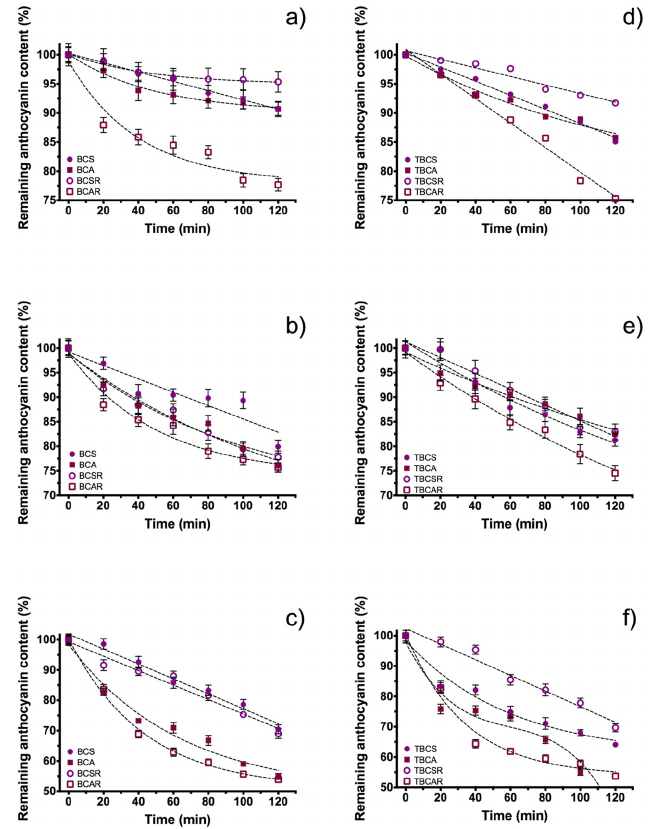
Figure 5. Anthocyanin content as function of time at different temperatures; ( a , d ) at 40 °C, ( b , e ) at 60 °C, and ( c , f ) at 80 °C. Samples extracted with ethanol/citric acid (BCS) and ethanol/acetic acid (BCA), samples after resin column (BCSR and BCAR), and microencapsulated samples using TEOS (TBCS, TBCA, TBCSR, TBCAR).